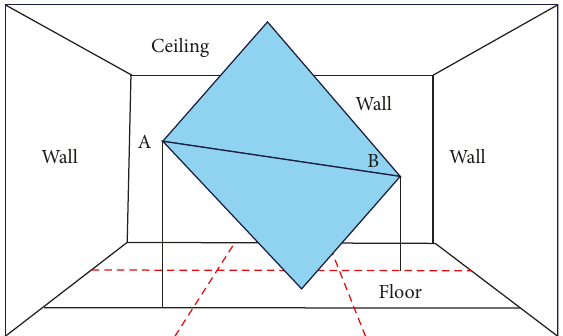
Figure 1: Layout of the test scene within the area.